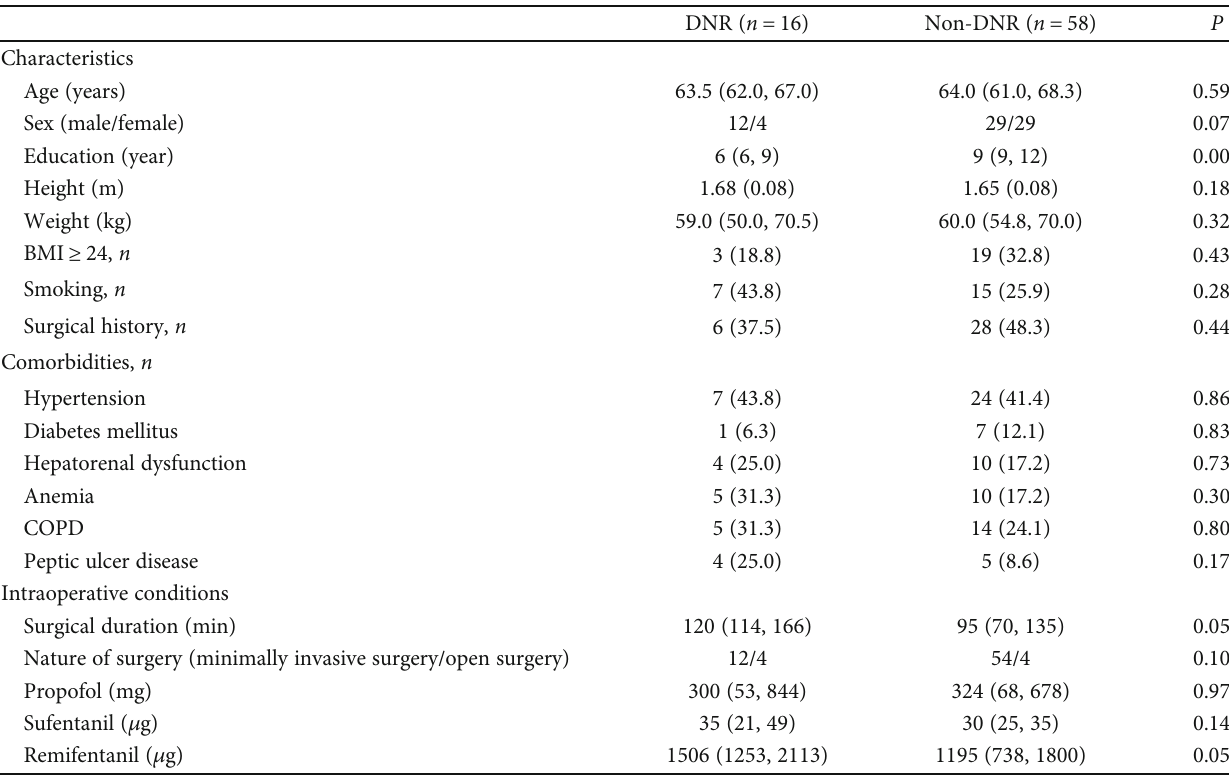
Table 1: Baseline characteristics.